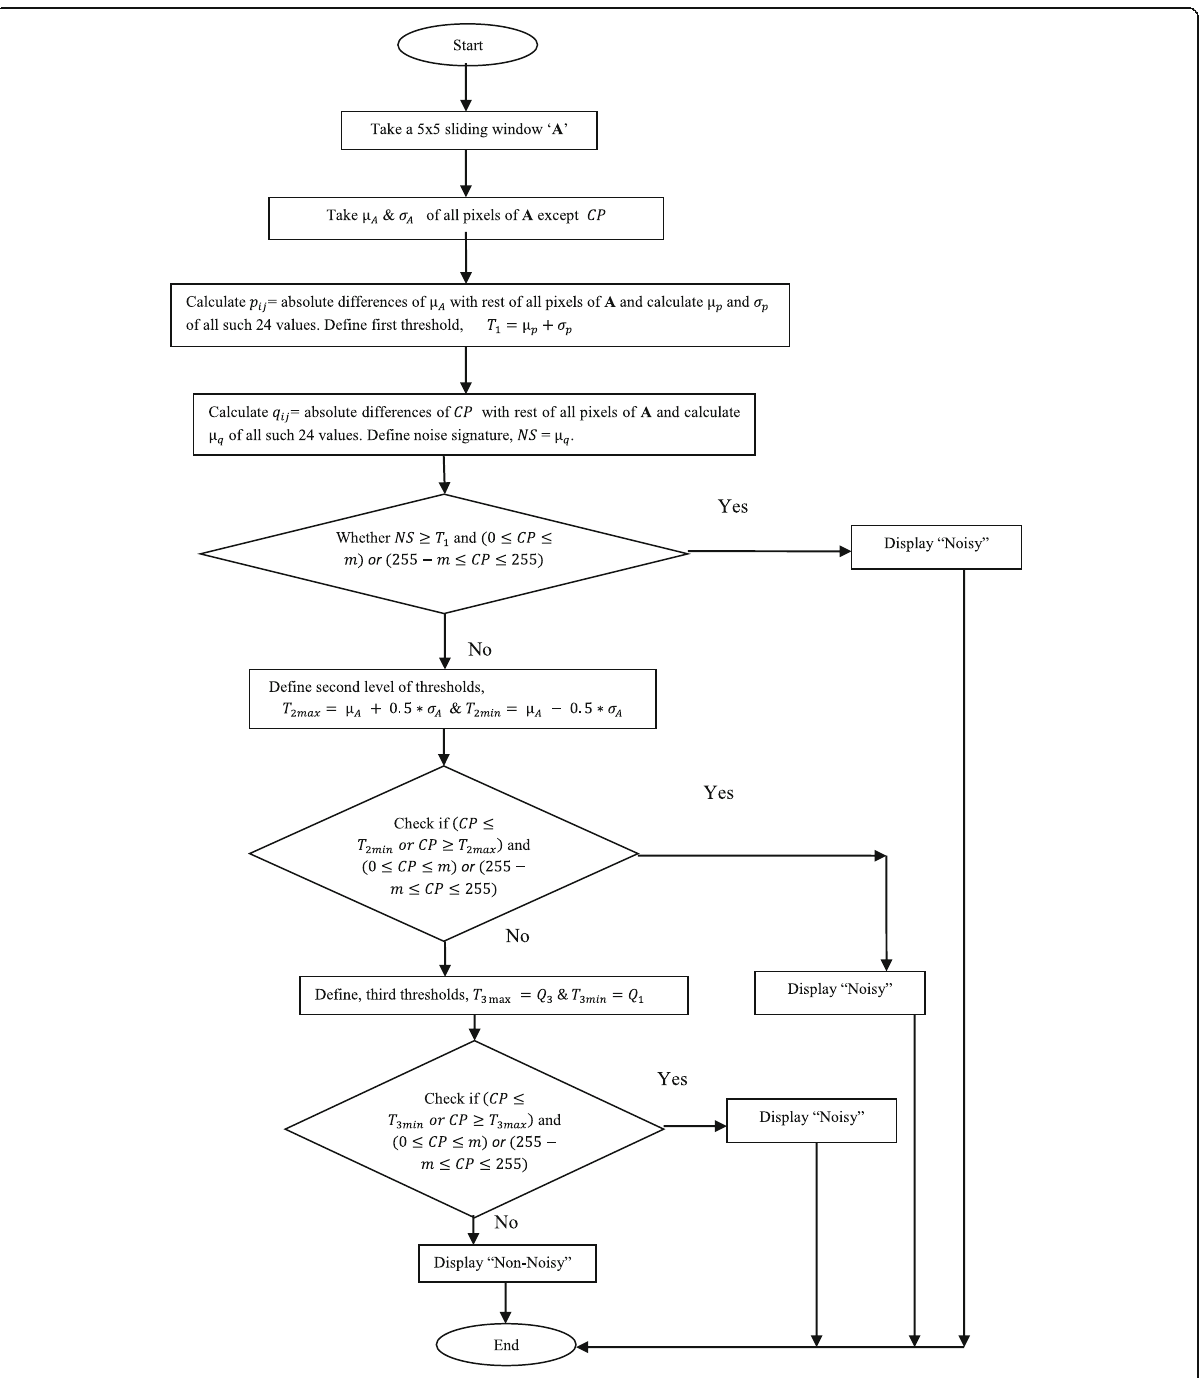
Fig. 4 Flowchart of detection process of TTSD algorithm. Legends: NS , noise signature; m , noise intensity Step VII: For all the noisy pixels, the median value is computed by using only the noise-free pixels surrounding it.